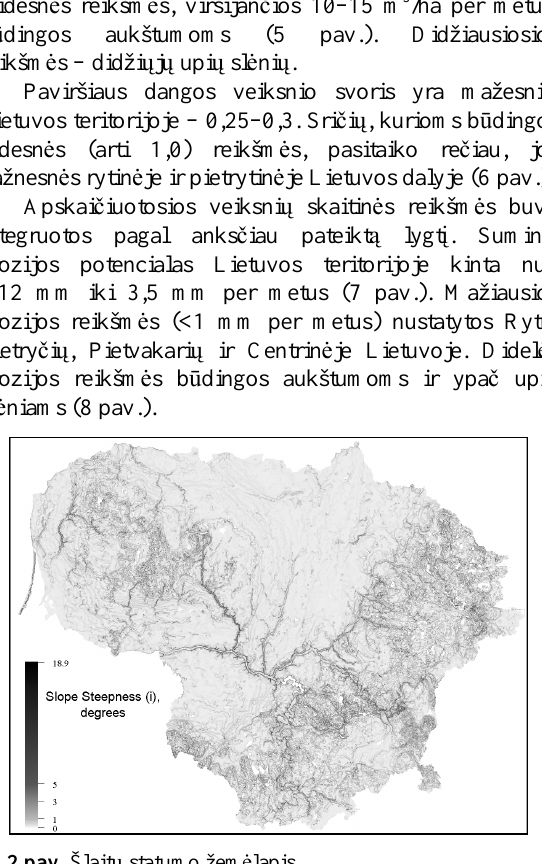
Fig 2 . Slope steepness